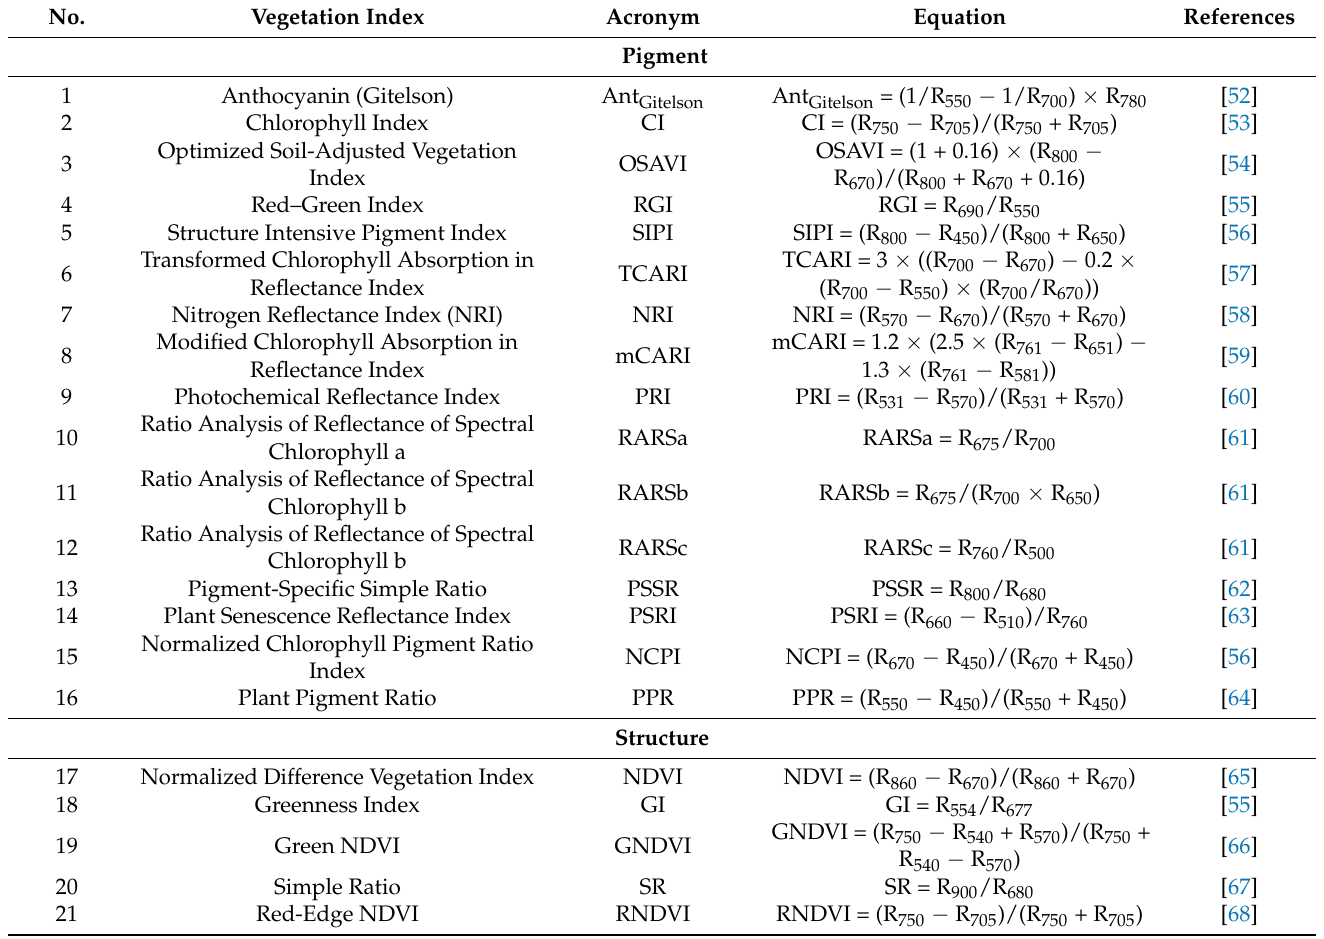
Table 2. Extraction of vegetation indices (VIs) from hyperspectral imagery